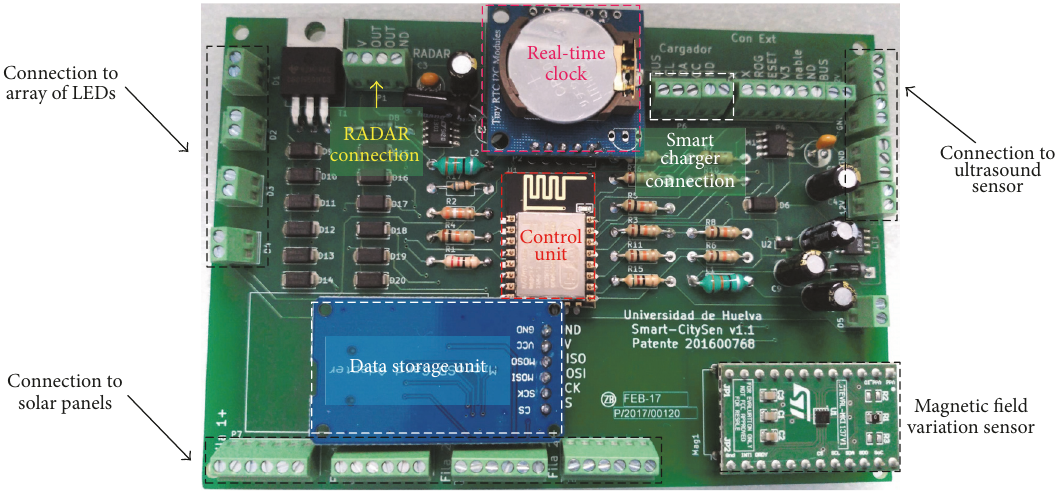
Figure 2: Outline of the inner electronics of the prototype